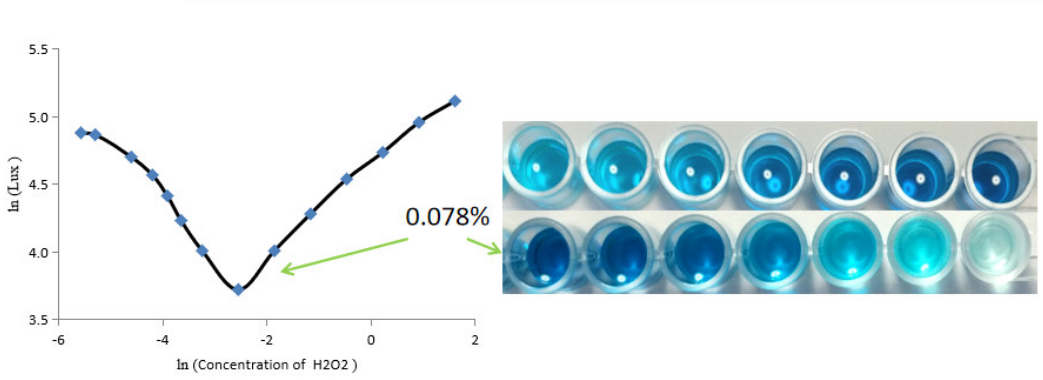
Figure 3. Qualitative observation ( right ) and quantitative curve ( left ) of the relationship between the H 2 O 2 concentration and light